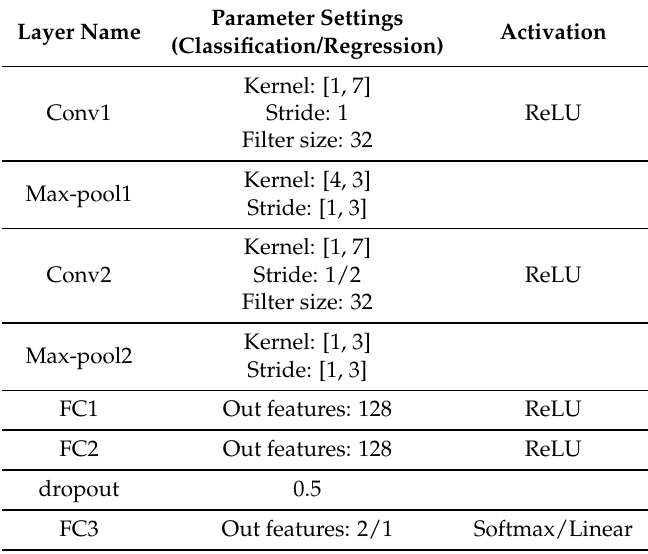
Table 1. Parameter settings of the 1D CNN